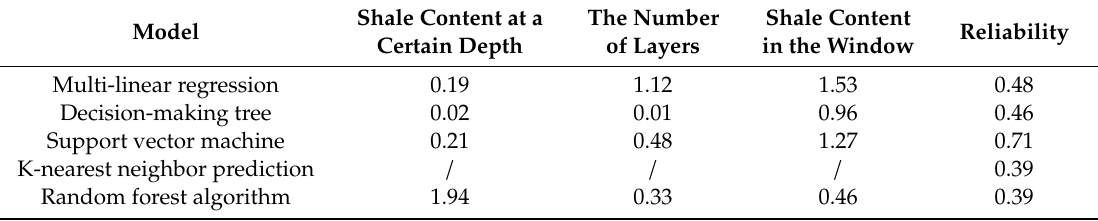
Table 1. The weight of each factor obtained by five machine learning methods and the reliability of each